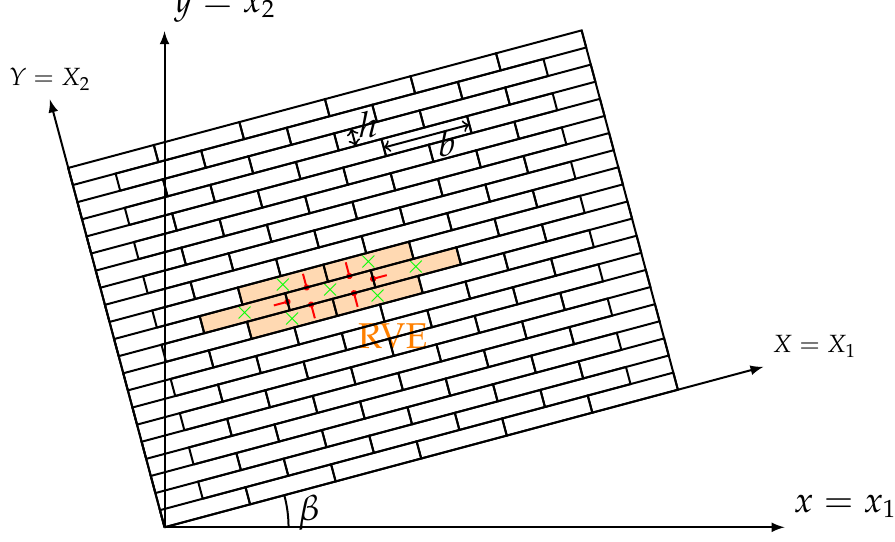
Figure 1. Schemes of the considered assembly and